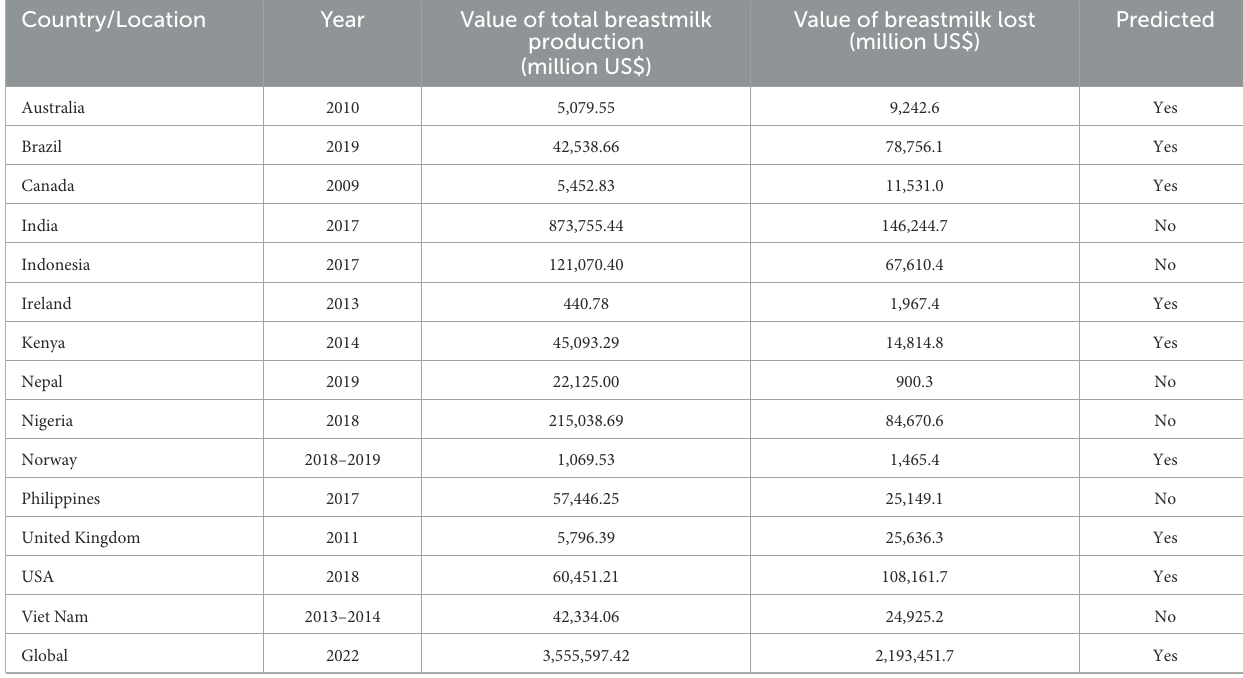
TABLE 5 Estimated production values and “lost milk” by